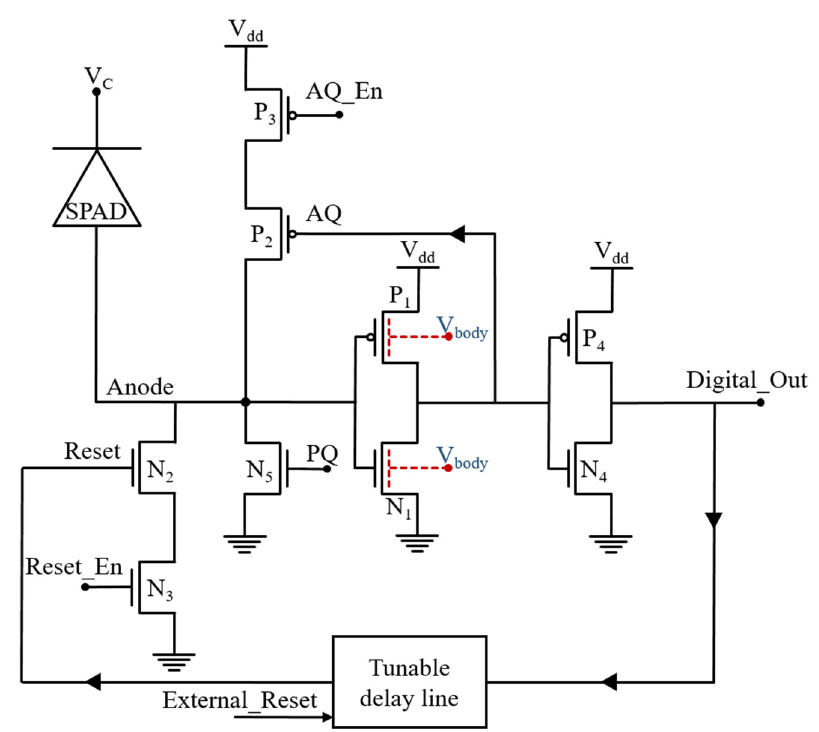
Figure 5. Schematic of the proposed body biased, inverter base AQAR circuit.